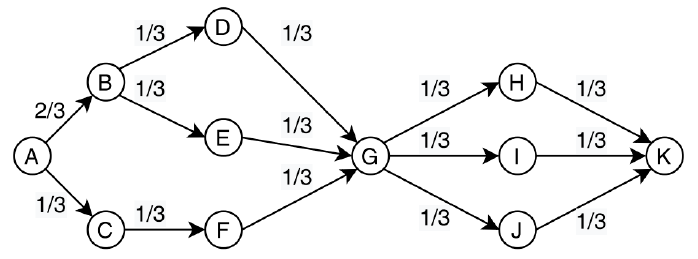
Figure 3. An example of calculating the value of 𝑔 (cid:3045)(cid:3038) (cid:4666)𝑒(cid:4667). SRC splits each flow onto multiple paths without considering packet